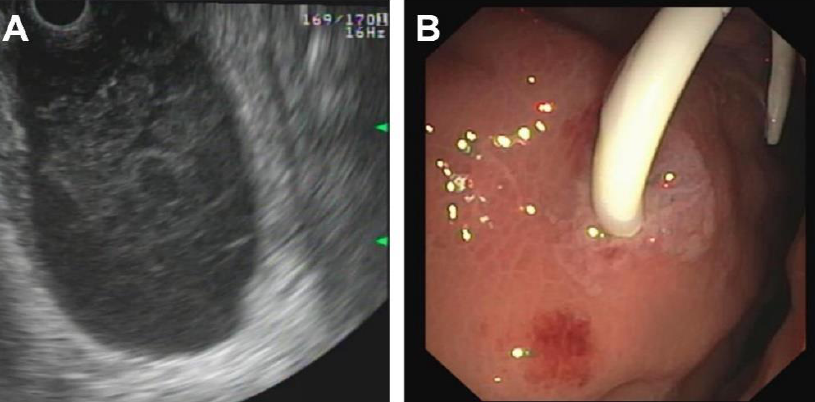
Figure 4. Transgastric endosonography showing a retention at the site of rupture ( A ). Transgastric placement of a pigtail drain ( B ).